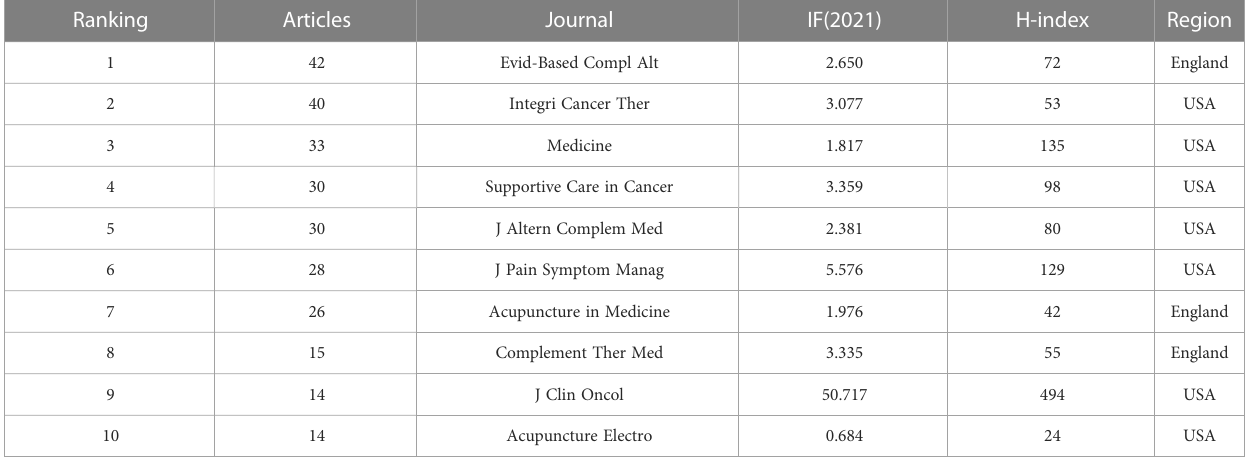
TABLE 6 Top 10 journals related to studies on acupuncture for cancer pain.